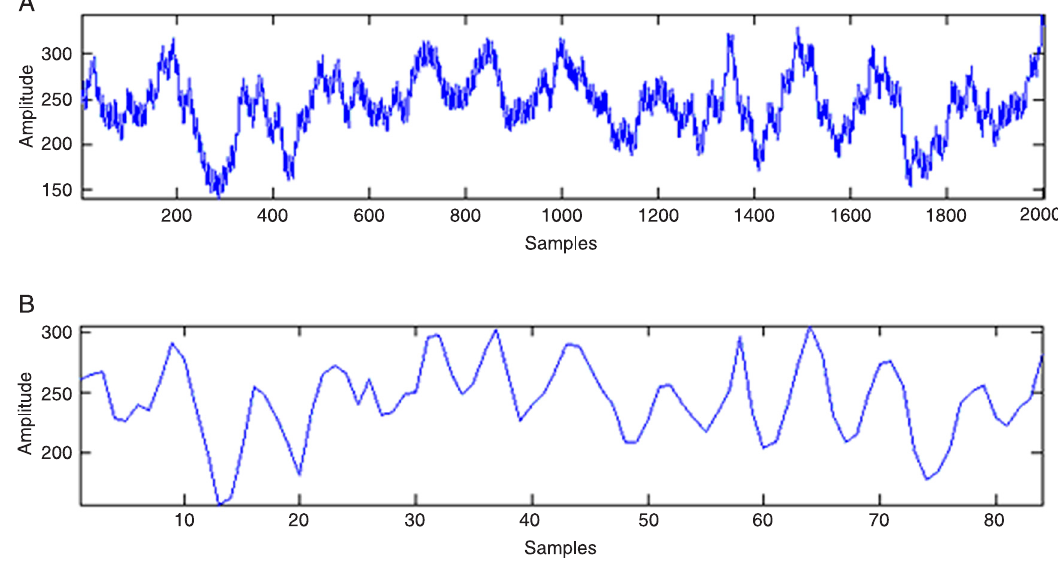
Figure 3. Electrogastrogram before (A) and after (B) subsampling and